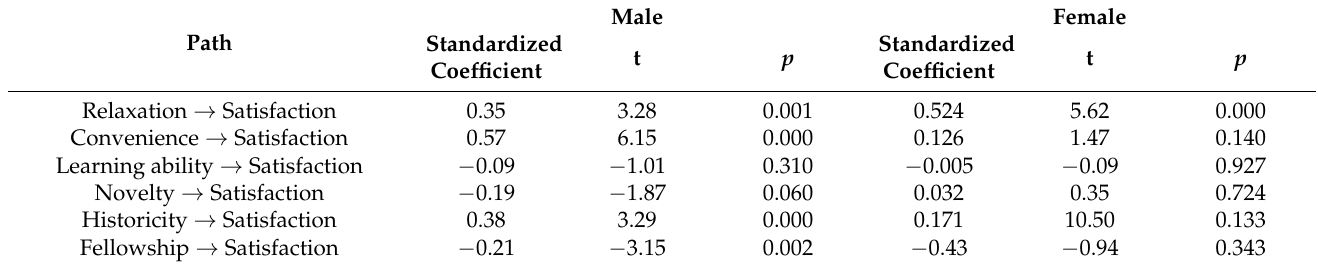
Table 7. Multiple group path analysis results (male vs. female).